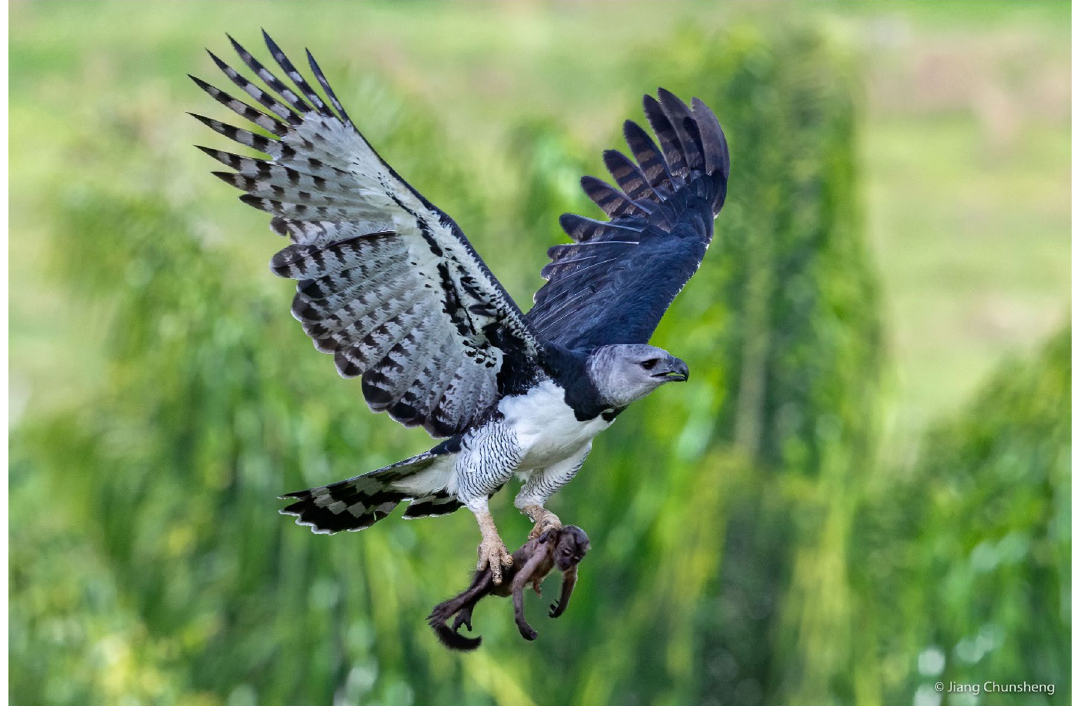
Figure 1. Harpy eagle ( Harpia harpyja ) arriving at a nest with a brown capuchin monkey (photo: Jiang